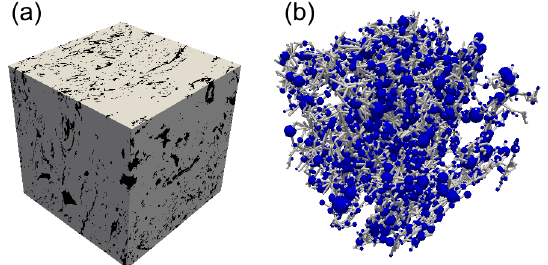
Figure 2. (a) A 600 3 -voxel (27cm 3 ) cubic central region of the binary image generated from the X-ray micro-computed tomogra- phy image of one of the peat samples from the depth of 40–45cm. The gray region denotes solid material (water and organic matter), and black regions denote void space (air). (b) The largest cluster of interconnected pores, or a pore network, extracted from the cubic image. The presentation of the network follows stick-and-ball ge- ometry: pores are depicted as blue spheres, and throats are straight gray cylinders between connected